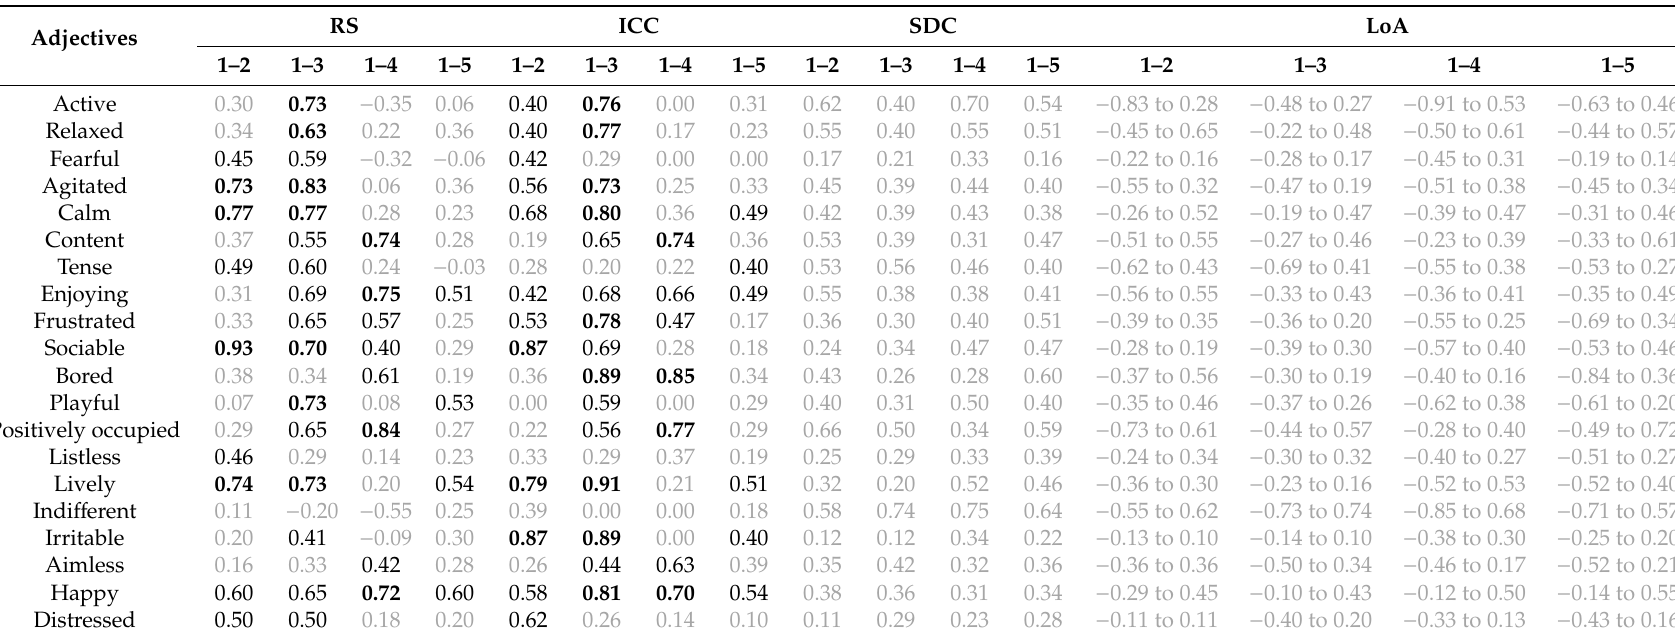
Table 3. Statistical parameters (Spearman’s rank correlation coe ffi cient: RS, intraclass correlation coe ffi cient: ICC, smallest detectable change: SDC, limits of agreement: LoA) for the comparison of the five farm visits (1–5) for the adjectives of the Qualitative Behavior Assessment, indicating poor (normal type, gray color), acceptable (normal type, black color), and good (bold type, black color) reliability or agreement,